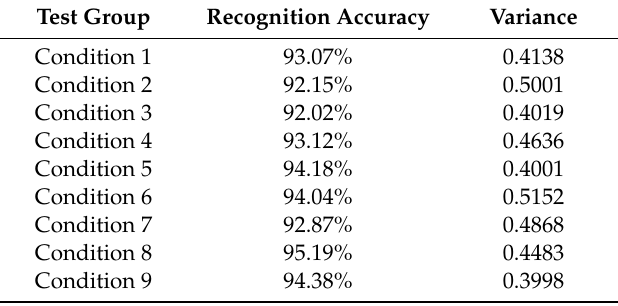
Table 8. The recognition accuracy under di ff erent operating conditions using